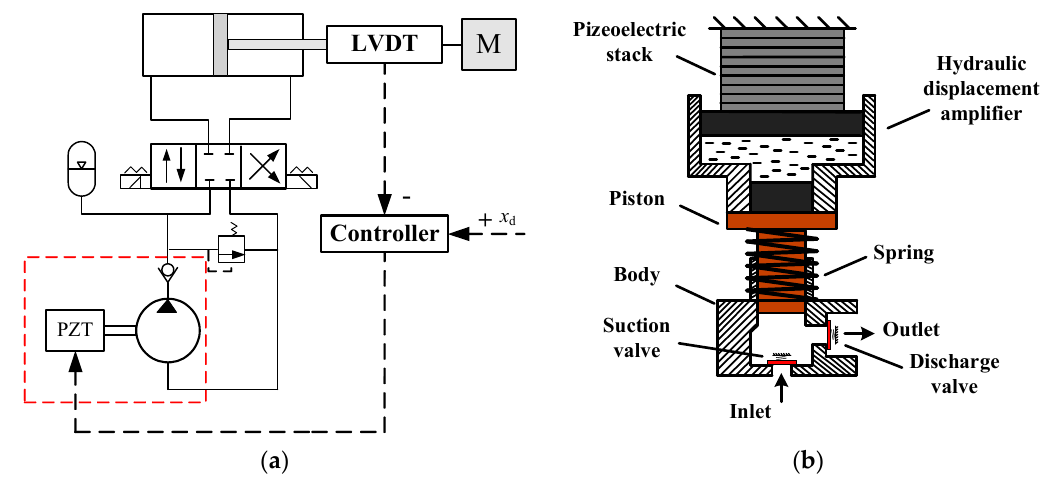
Figure 1. System principle and design: ( a ) Principle of the actuator; ( b ) Schematic diagram of the PZT pump.